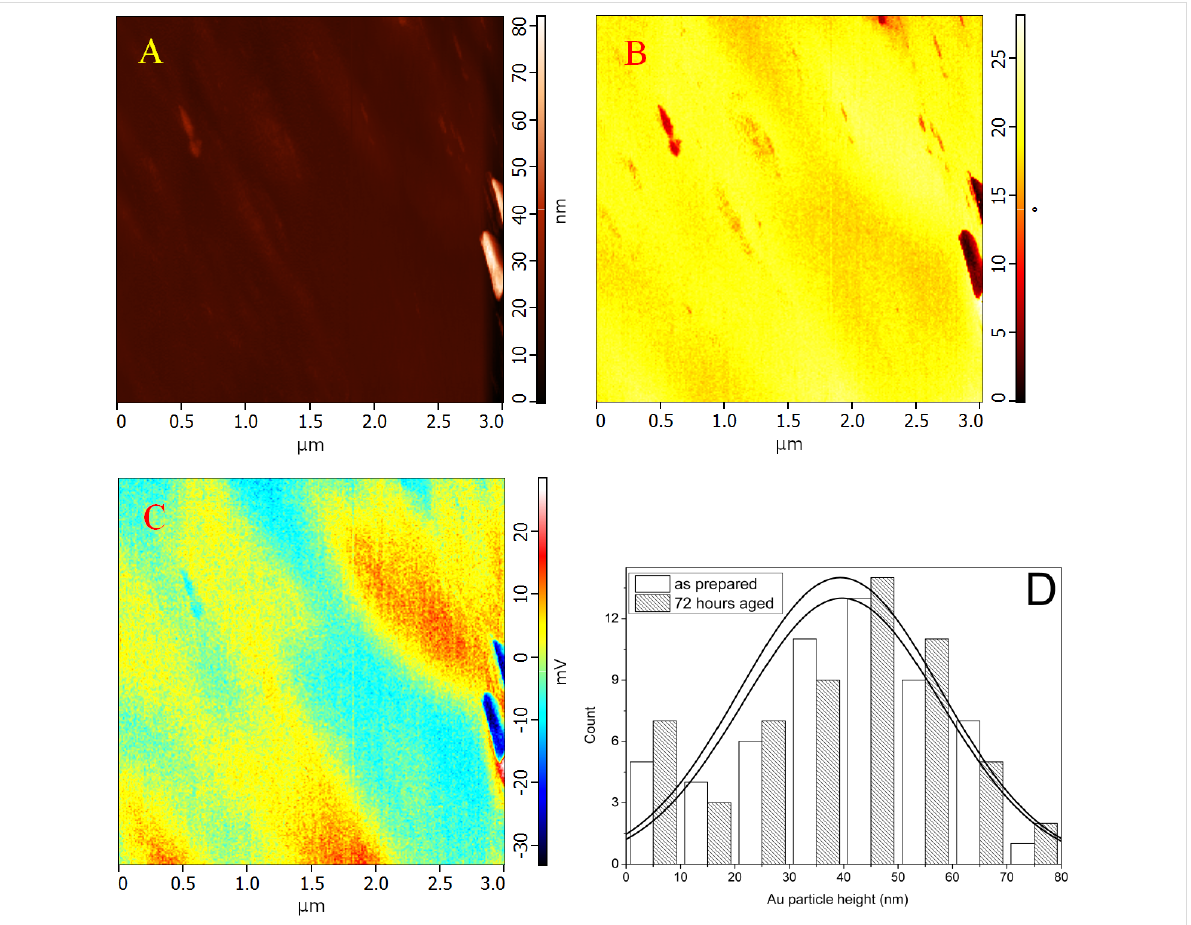
Figure 1: (A) Topographical and (B) phase-shift image, and (C) surface contact potential map of Au nanoparticles on Bi 2 Se 3 (as prepared); (D) histogram of the Au NP height distribution for the as-prepared sample and after 72 h.